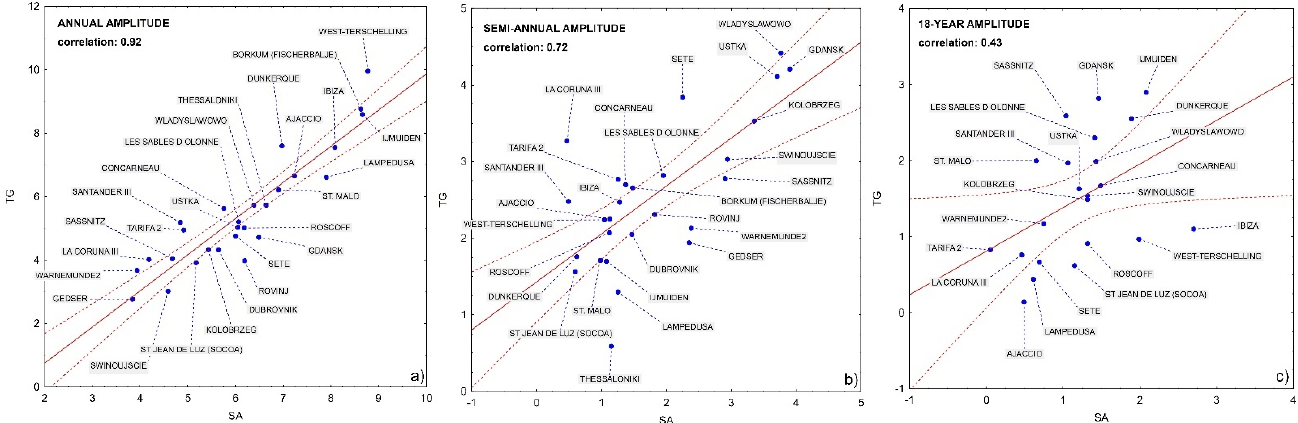
Figure 4. ( a ) Annual, ( b ) semiannual and ( c ) 18.61-year amplitudes of the seasonal cycle based on SA and TG time series. The correlation coefficients for amplitude were calculated based on SA and TG data (blue circles-dispersion plot; area marked by red dashed lines-95% confidence interval of the regression line). The amplitude units are centimetres.